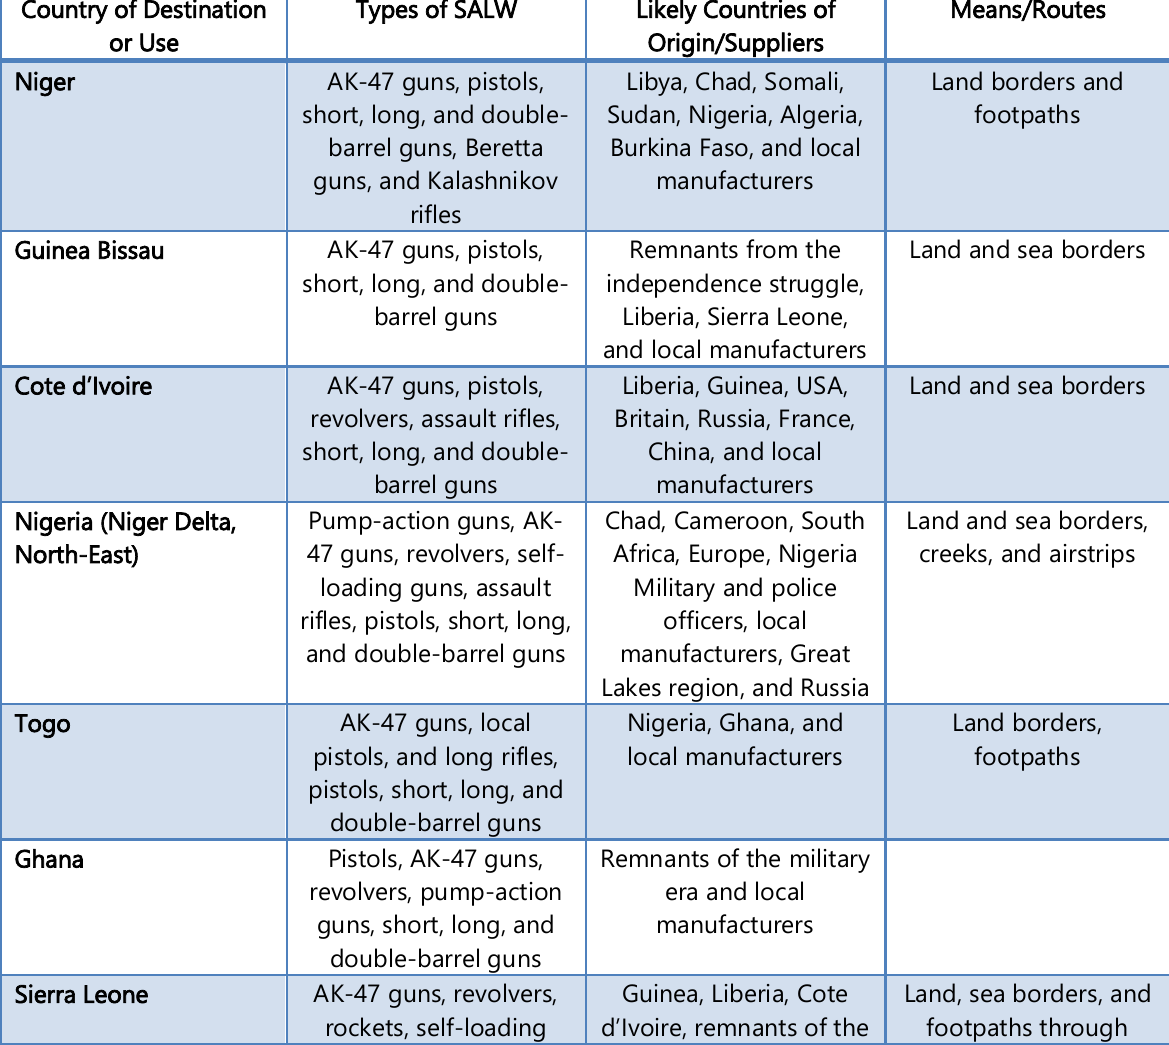
Table 1: Types, Sources, Routes, and Destinations of SALW in West Africa (Source: GIABA Report 2013) Country of